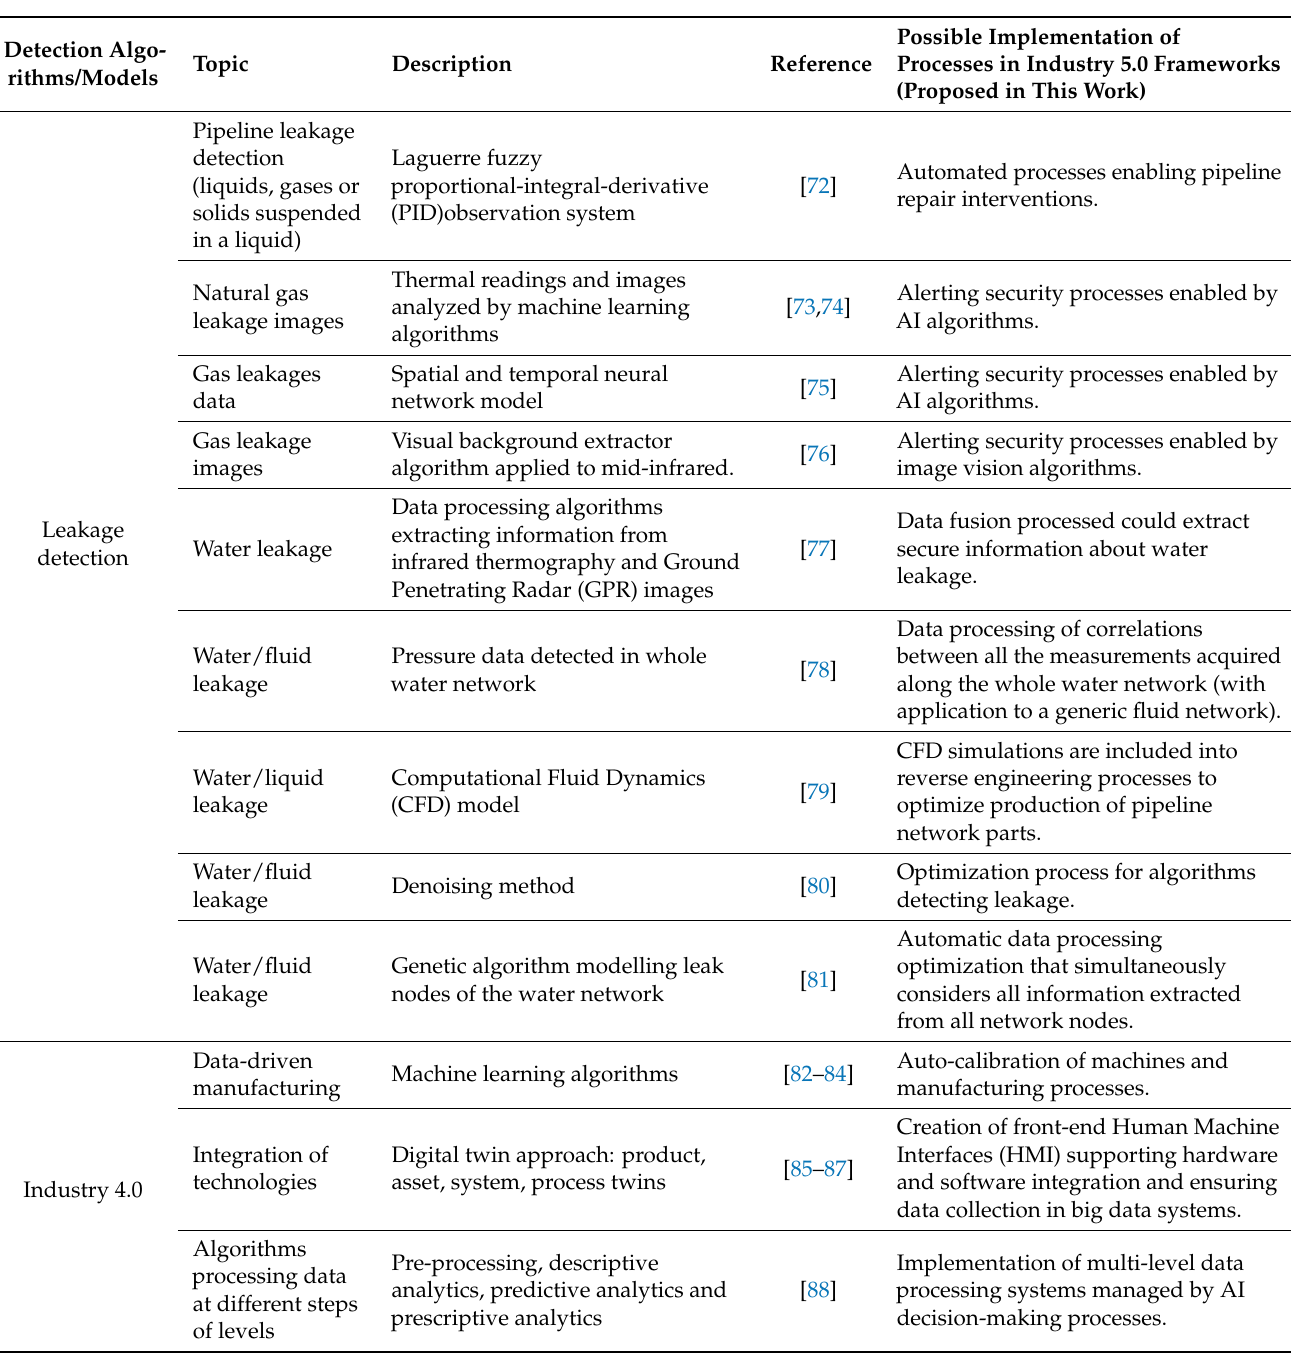
Table 3. State of the art: detection algorithms and possible implementation of processes in an Industry 5.0